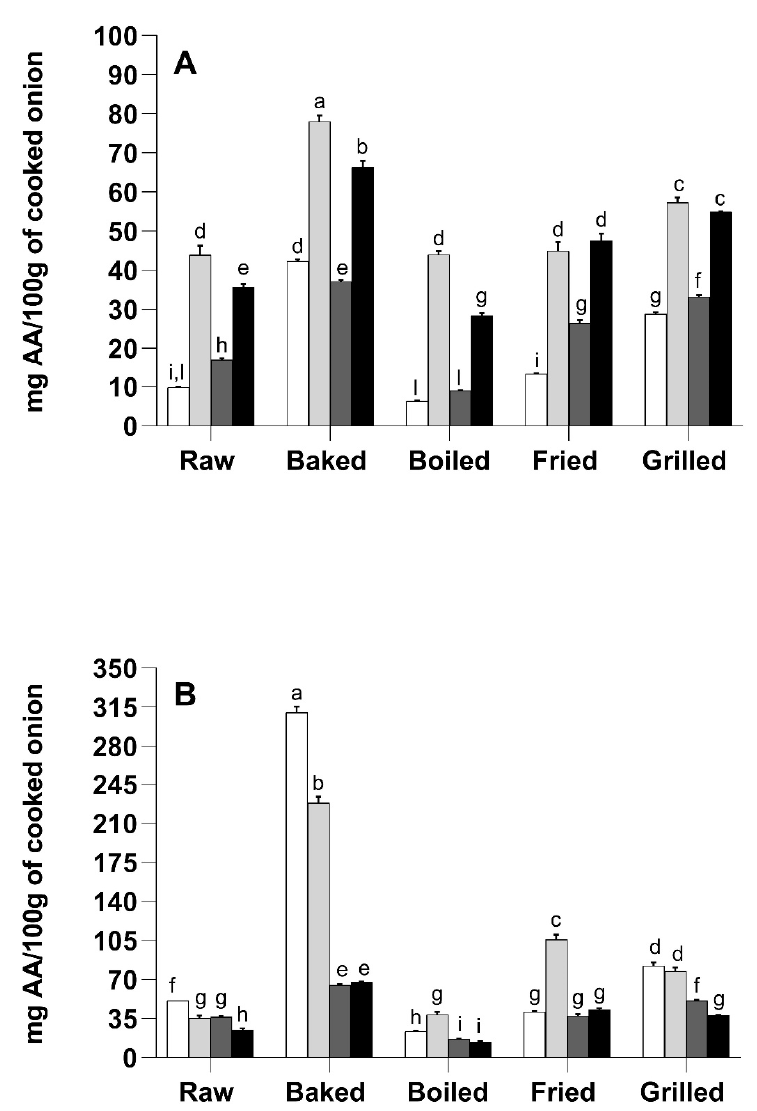
Figure 5. Effect of different cooking methods and in vitro digestion on yellow-skinned (YSO) and red-skinned (RSO) onions antioxidant activity. ( A ) YSO antioxidant activity as determined by the ABTS assay in the methanolic/formic acid extract (white) and after in vitro digestion (light grey bars). RSO antioxidant activity as determined by the ABTS assay in the methanolic/formic acid extract (dark grey bars) and after in vitro digestion (black bars). ( B ) YSO antioxidant activity as determined by the FRAP assay in the methanolic/formic acid extract (light grey bars) and after in vitro digestion (grey bars). RSO antioxidant activity as determined by the FRAP assay in the methanolic/formic acid extract (dark grey bars) and after in vitro digestion (black bars). Results are expressed as mg of ascorbic acid equivalent/100 g of raw or cooked onion. Different letters indicate that the values are significantly different ( p < 0.05).